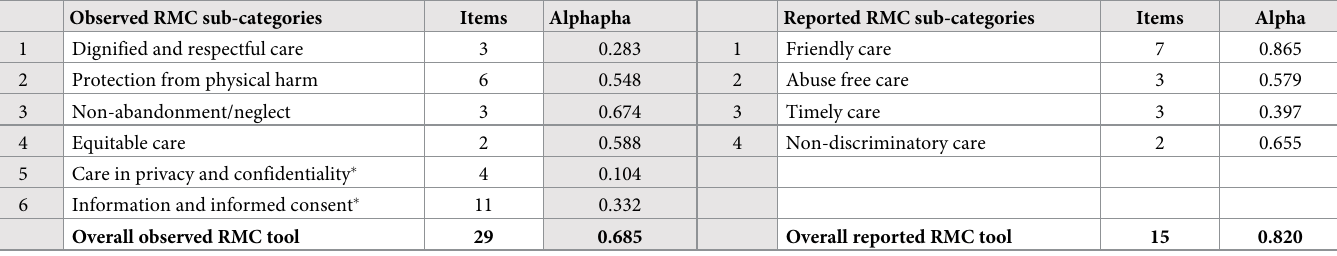
Table 1. Breakdown of sub-categories for the observed and reported RMC